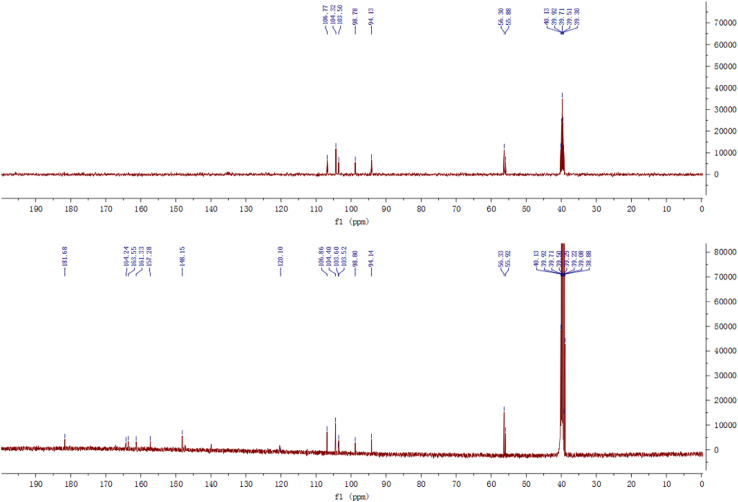
13C-NMR and DEPT spectrum of compound 5.